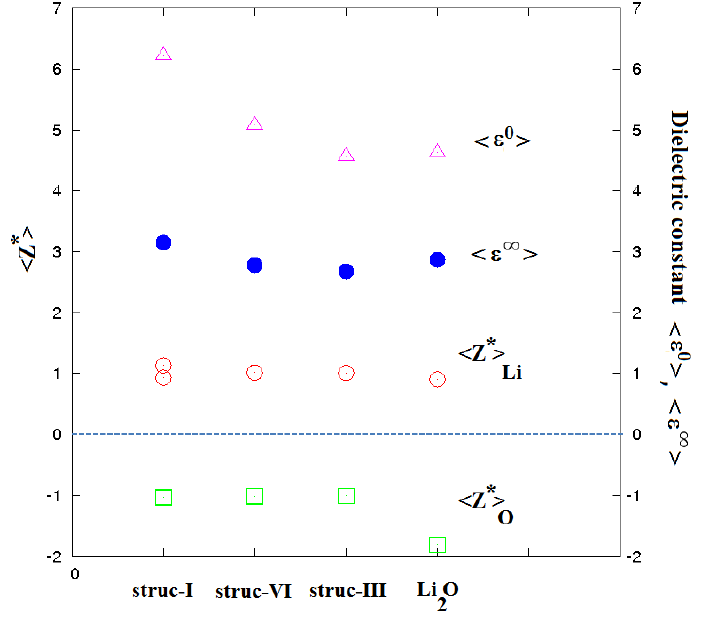
Figure 7. The computed orientationally averaged static dielectric constants of lattice contribution <ε 0 > and electronic contribution <ε ∞ >; and isotropically averaged of atomic Born charges, <Z * > of Li and O for few selected structures of Li 2 O 2 : structure-I (struc-I), III (struc-III), VI (struc-VI). Calculated results for the Li 2 O crystal are also included for